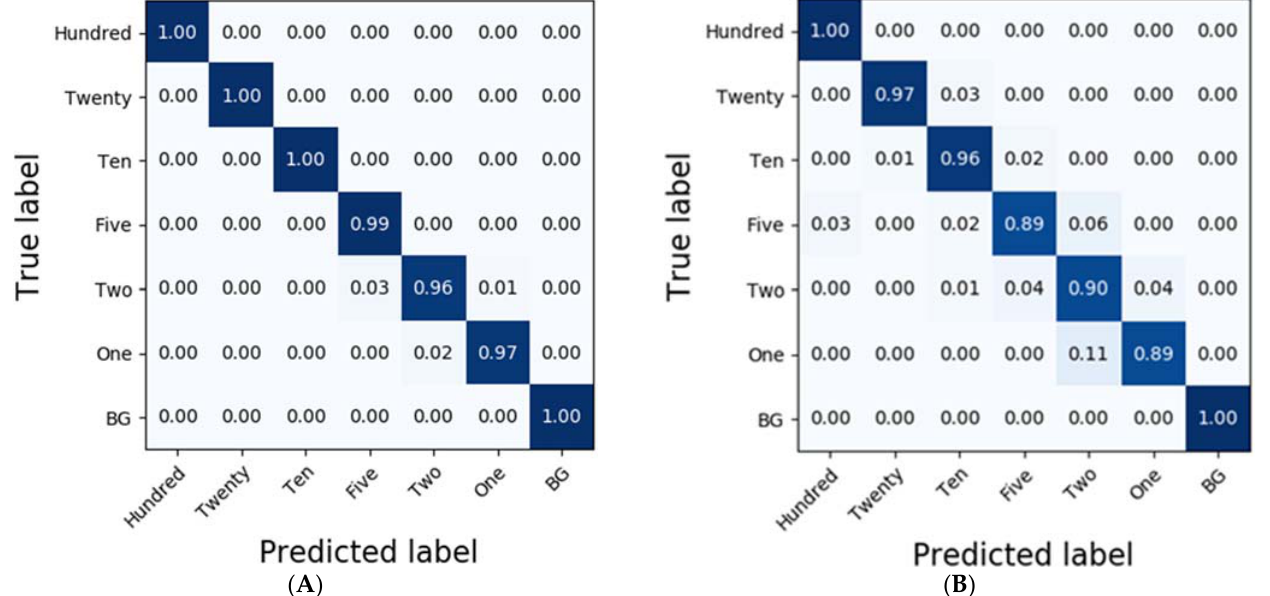
Figure 6. Confusion matrix of the classification result for potato according to the dilution of the residues using CNN-1D. The calibration result ( Ac = 0.99) is ( A ) and the validation result ( Av = 0.94) is ( B ).